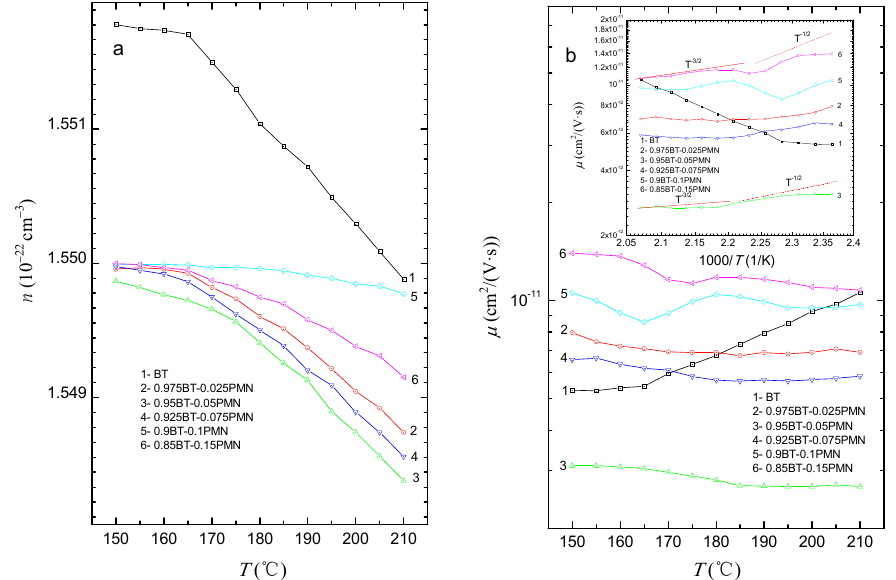
Fig. 11 (a) Concentration of charge carriers as a function of temperature and (b) mobility of charge carriers as a function of temperature for (1  x )BT– x PMN ceramics. Inset shows the same as a function of 1000/ T , presenting grain boundary and acoustic phonon scattering as the dominant carrier scattering mechanism in the low temperature and high temperature ranges,